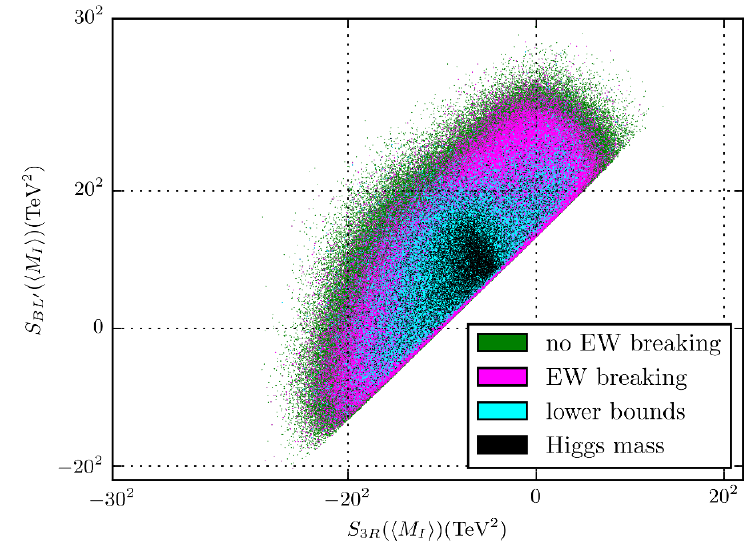
Figure 2. Plot of the 100 million initial data points for the RG analysis evaluated at M 4,351,809 green points lead to appropriate breaking of the B purple points also break the EW symmetry with the correct vector boson masses. The cyan points correspond to 342,236 initial points that, in addition to appropriate B satisfy all lower bounds on the sparticle masses. Finally, as a subset of these 342,236 initial points, there are 67,576 valid black points which lead to the experimentally measured value of the Higgs boson